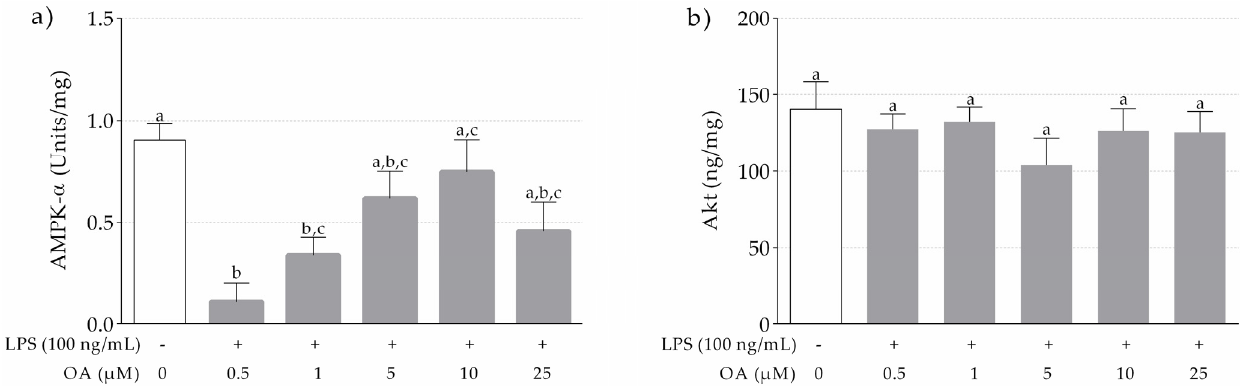
Figure 2. Effects of OA on AMPK- α ( a ) and Akt ( b ) in THP-1 macrophages induced by LPS. Control cells were incubated with DMSO. Experiments performed in triplicate. Different letters indicate significant difference ( p < 0.05) by one-way ANOVA analysis and Tukey’s post hoc test.